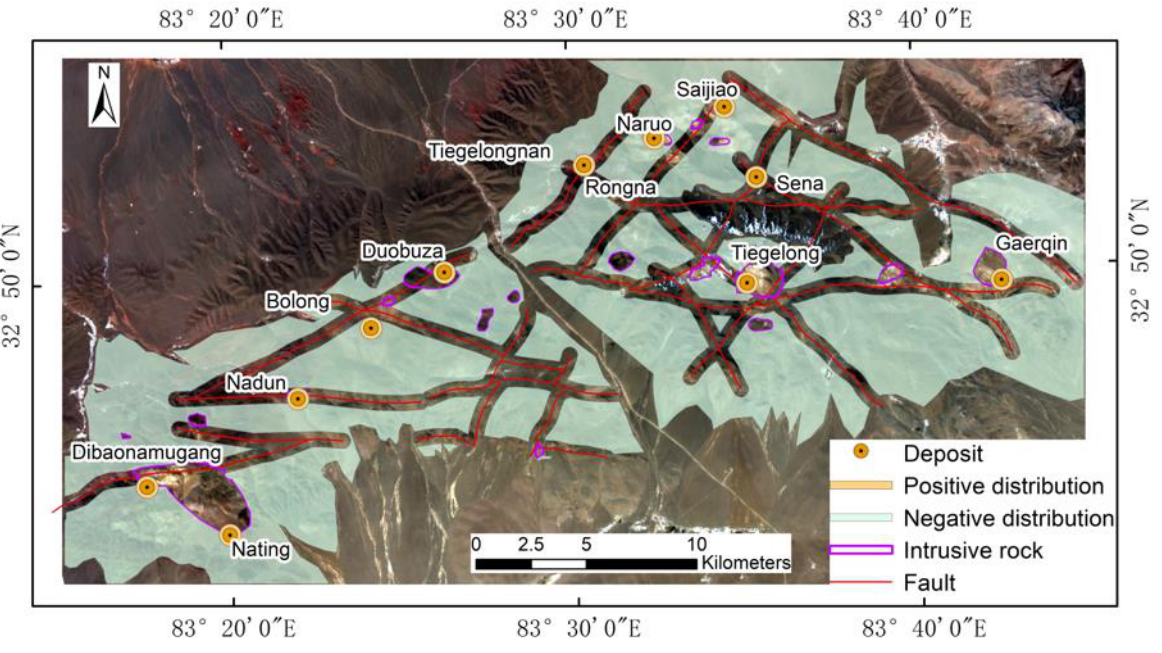
Figure 13. The distribution of samples. Positive samples are distributed in yellow circles, and negative samples are randomly sampled in the green area.